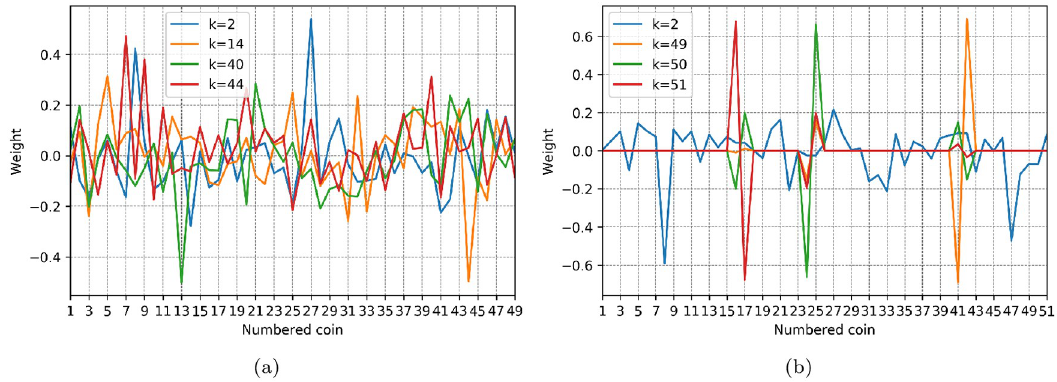
Fig 9. Factor weights. Contribution weight of each coin for the factors with the highest IPR. (a) Eigenvector weights associated with the predictor factors k = 2, 14, 40 and 44. (b) Eigenvector weights associated with the response factors k = 2, 49, 50 and